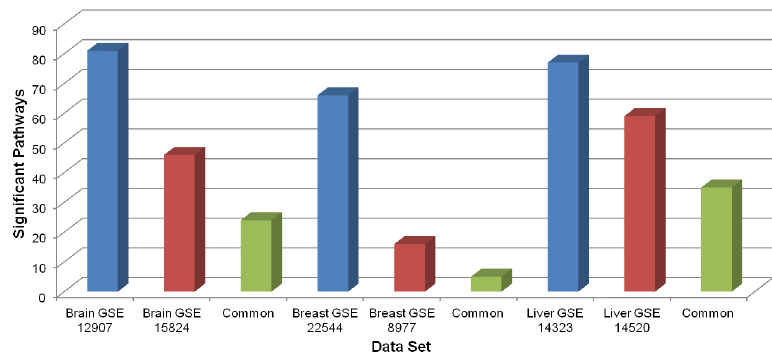
Figure 1. Commonality of significant pathways using the BPA analysis on the same cancer types.